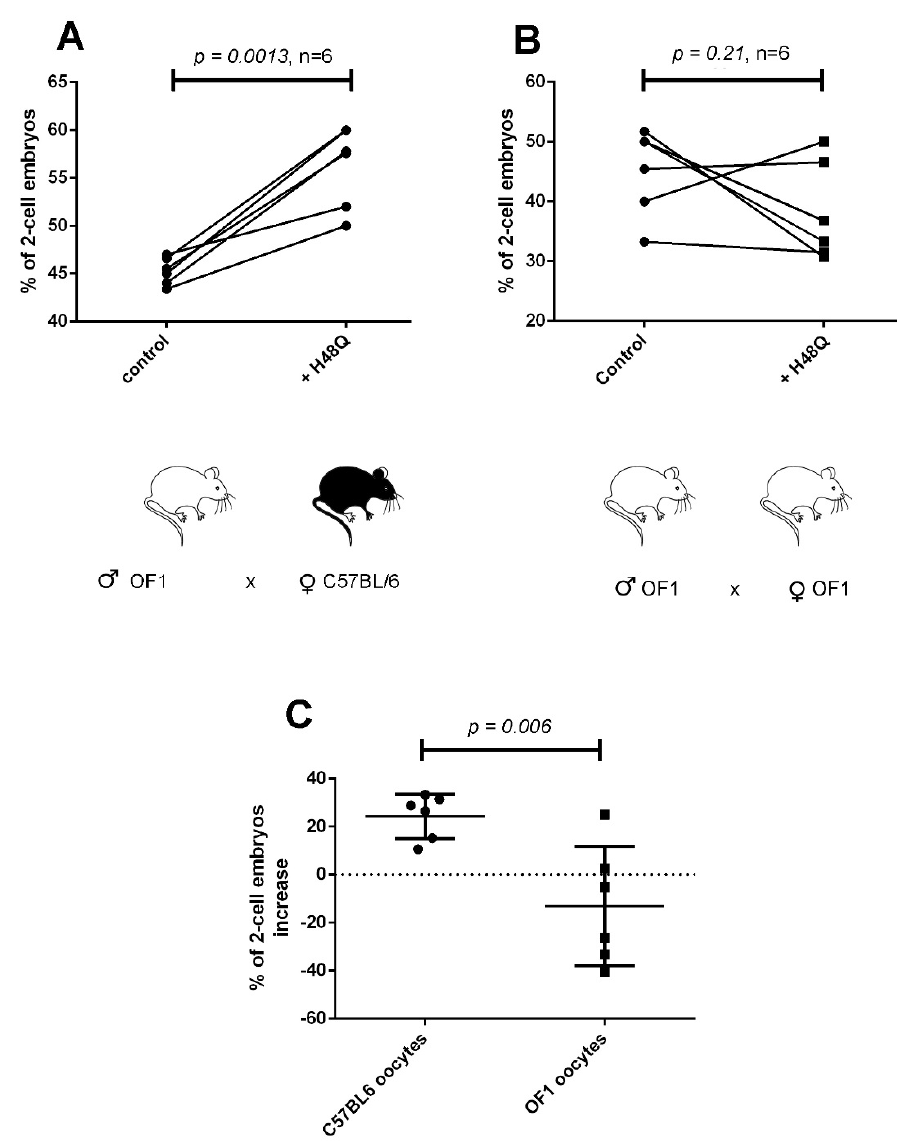
Figure 5. Impact of the strain origin of oocytes on H48Q-PLA2G10-induced improvement of IVF performed with OF1 sperm. ( A ) Percentages of two-cell embryos obtained with sperm from OF1 males and oocytes from C57BL/6 females. Sperm were untreated (control) or treated during capacitation with 200 nM H48Q-PLA2G10 as described above. ( B ) Percentages of two-cell embryos obtained with sperm and oocytes from OF1 males and females. Sperm were untreated (control) or treated during capacitation with H48Q-PLA2G10. ( C ) Comparison of the % of improvement of 2-cell embryos generated with sperm from OF1 males and oocytes from C57BL/6 or OF1 females as indicated. Statistical comparisons were made with paired t -test ( A , B ) or t -test ( C ).